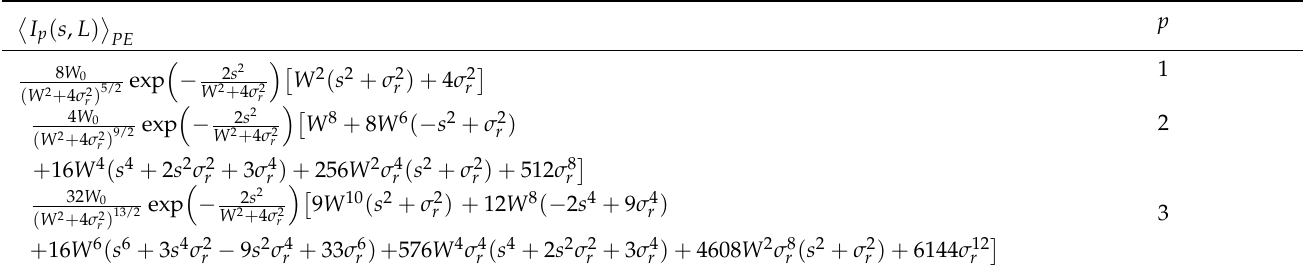
(cid:10) (cid:11) I p ( s , L ) for p = 1, 2 and PE